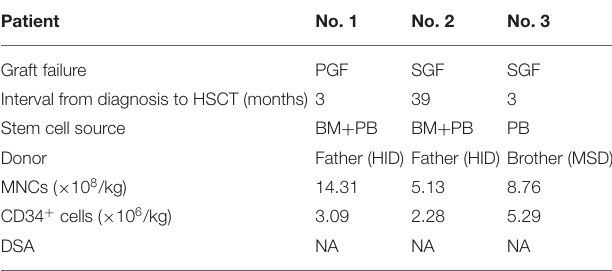
TABLE 2 | Characteristics of patients with graft